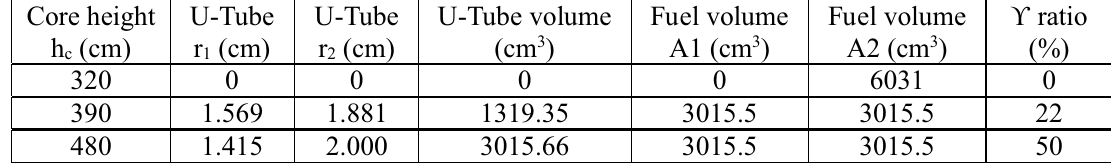
Table II. Examples of BBMSR geometry with U-Tube with respect to ϒ ratio.